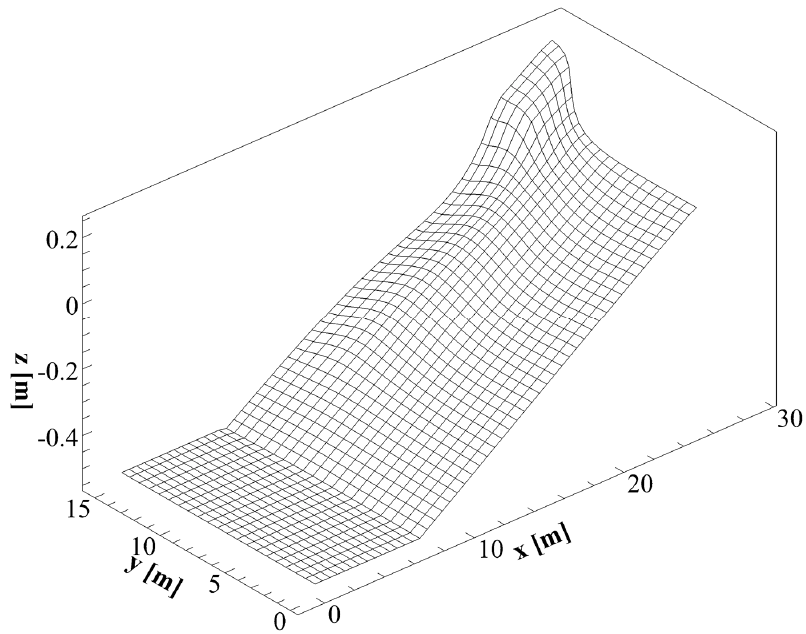
Figure 8. Test 4. Rip current. Three ‐ dimensional view of the bottom.